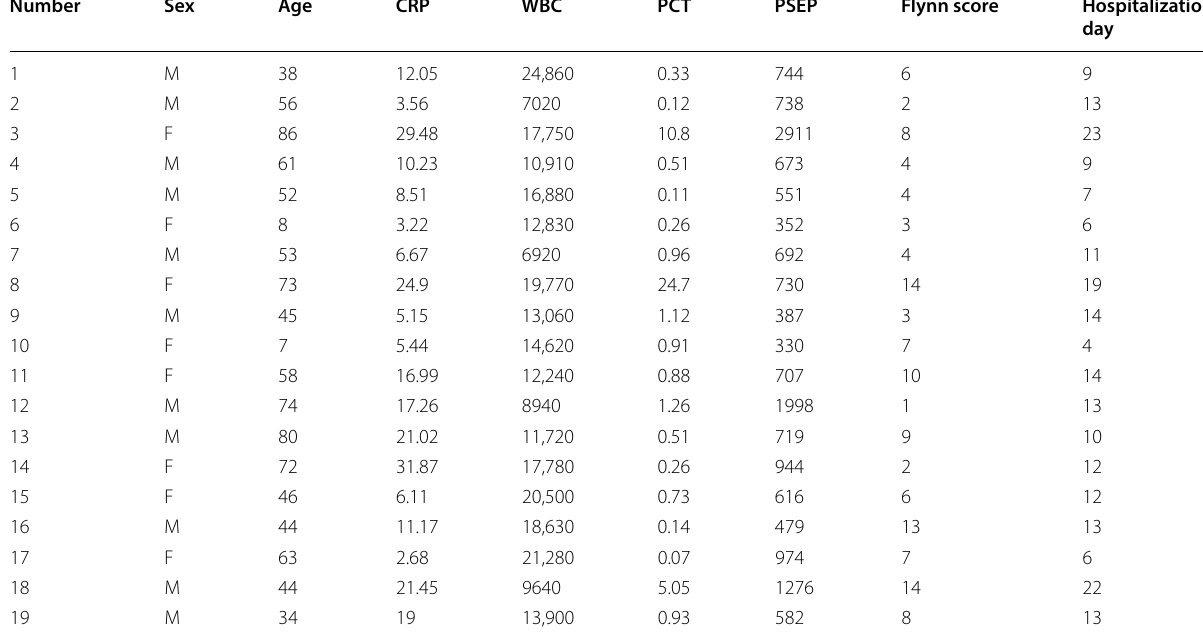
Table 1 Characteristics of study subjects (group 1: sepsis)